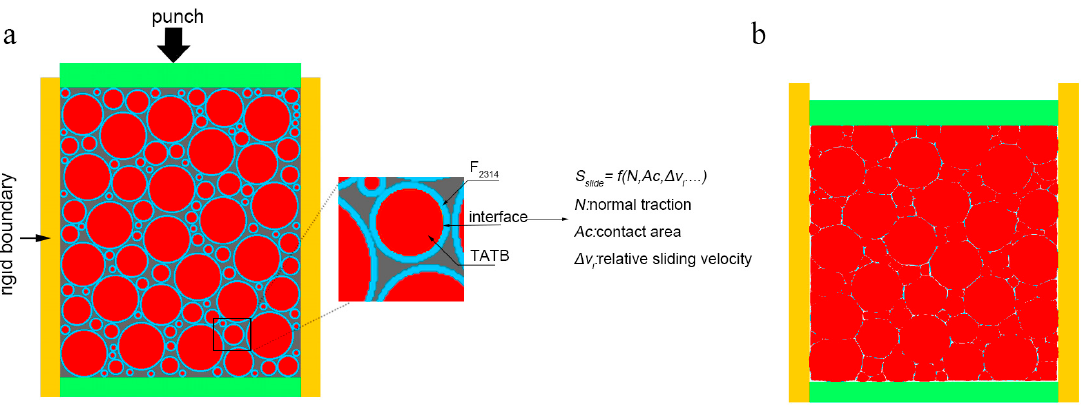
Figure 1. ( a ) Uniaxial compression model of PBX on mesoscale, ( b ) snapshot of final state of